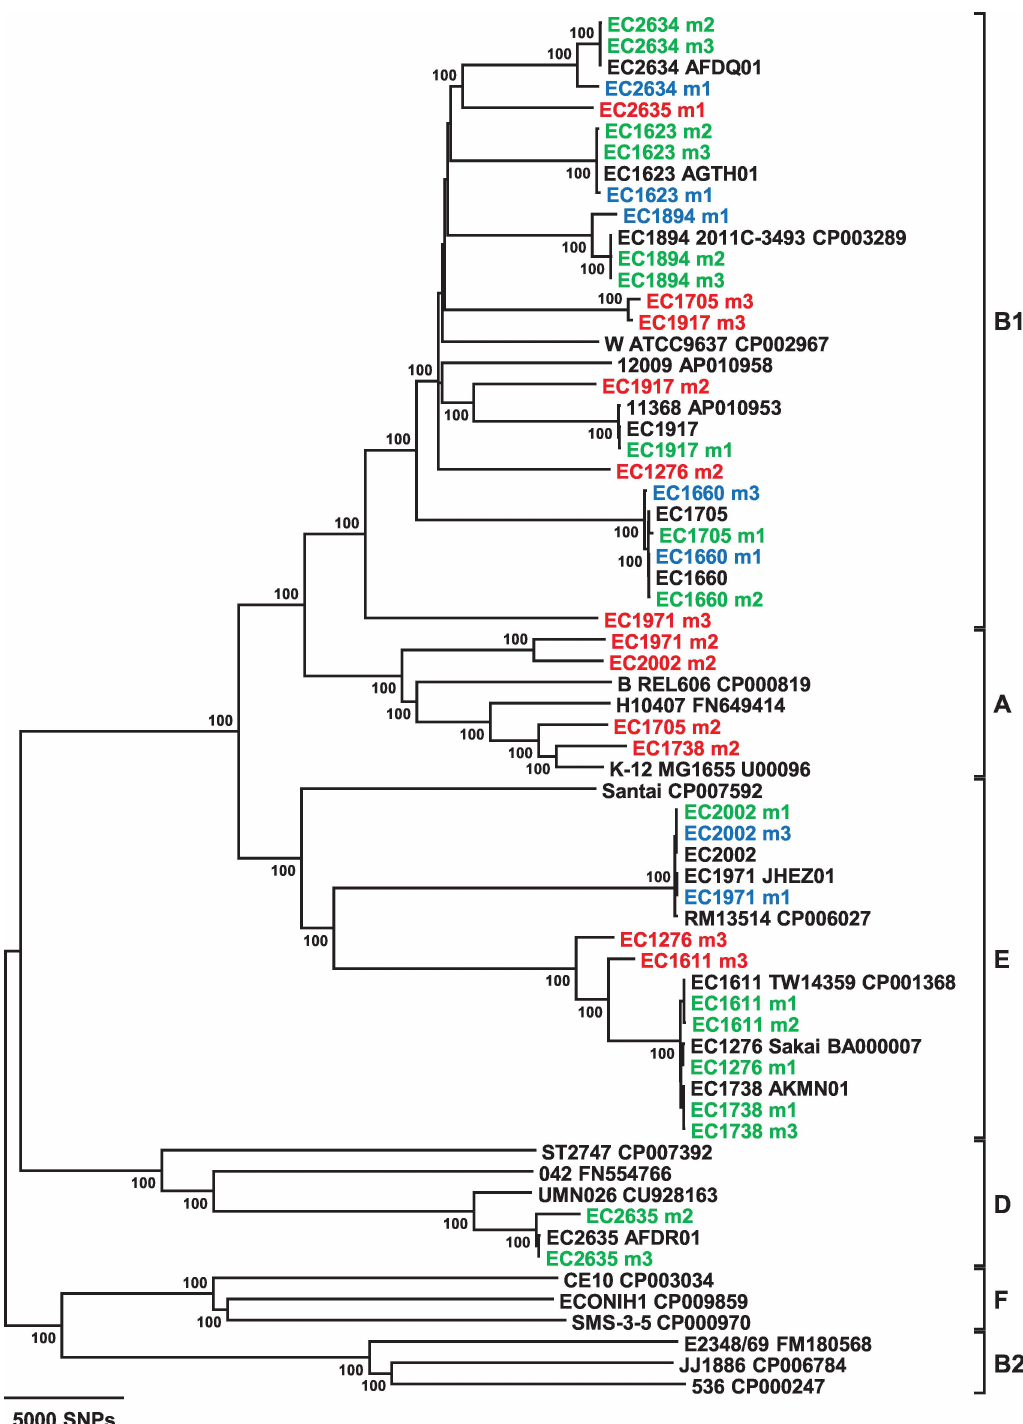
Fig 2. Phylogenetic relationships resulting from E . coli core gene SNP analysis of spiked STEC genomes, metagenomic samples, and other E . coli strains. This neighbor-joiningtree was constructed using a p distance matrix and 500 bootstrapreplications. Metagenomic samples are color-codedas follows: green, spiked STEC only E . coli detected in sample; blue, indigenous E . coli present but clusters with spiked strain; and red, indigenous E . coli present and does not cluster with spiked strain. Closedgenomestrains are labeledwith their strain name and GenBank accessionnumber. Phylogroupsare indicatedby the squarebrackets. Bootstrap values > 80% are given at the internal